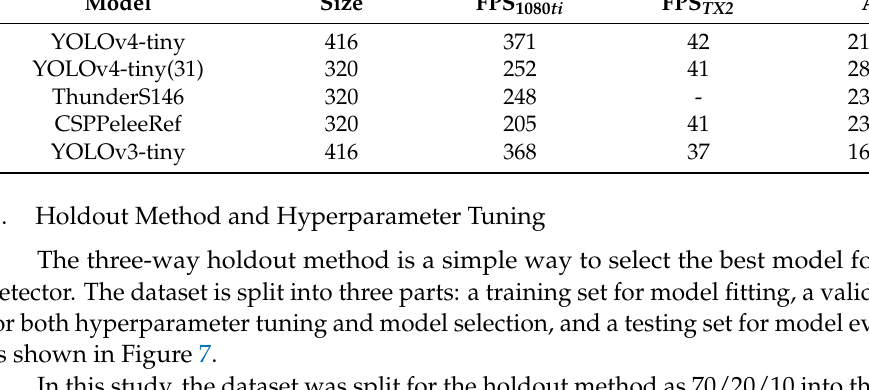
Figure 6. The structure of YOLOv4-Tiny-3l. Table 1. The performance of SOTA tiny models in the COCO dataset, C.Y. Wang 2020.